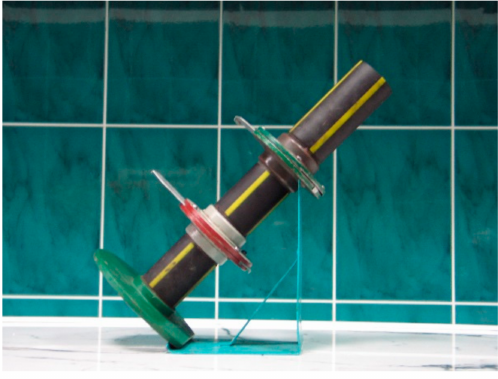
Figure 2. The column for testing the cement slurry